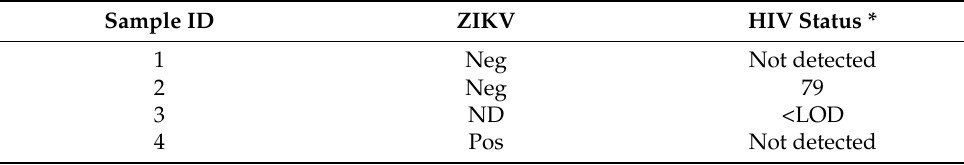
Table 4. ZIKV seroprevalence among HIV-positive